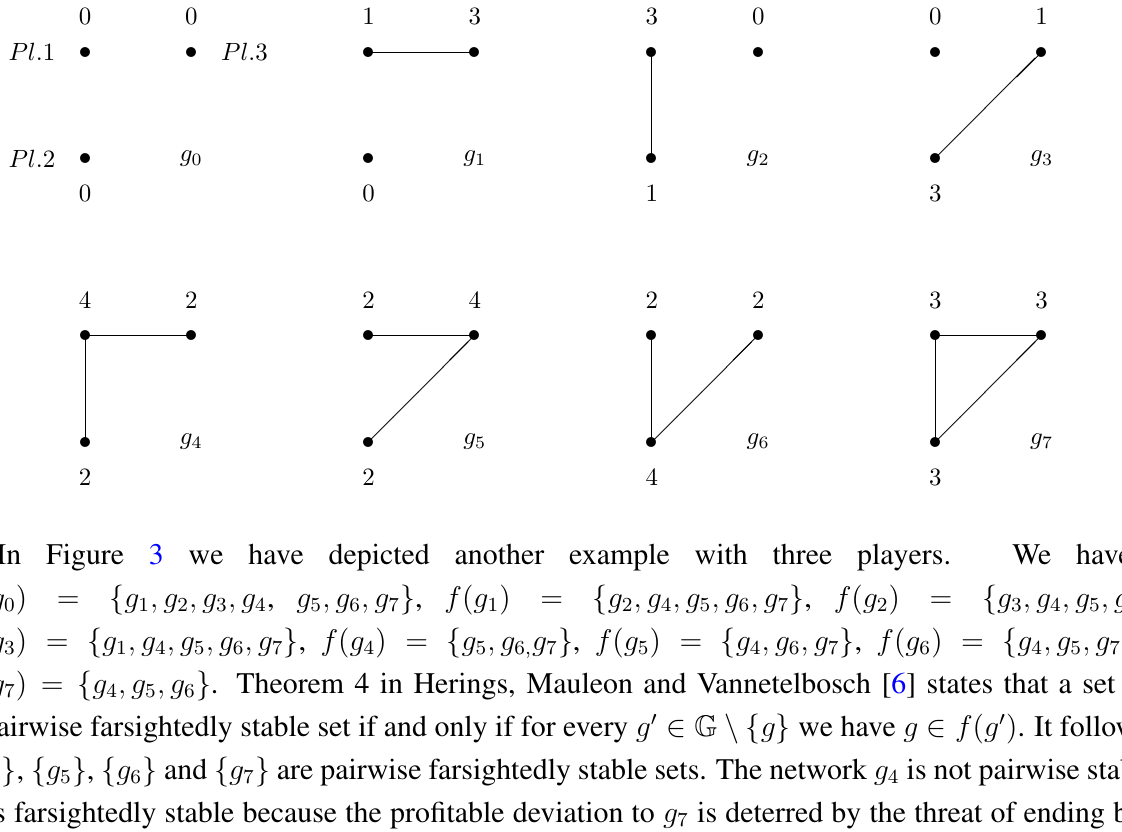
Figure 3. Another example with three